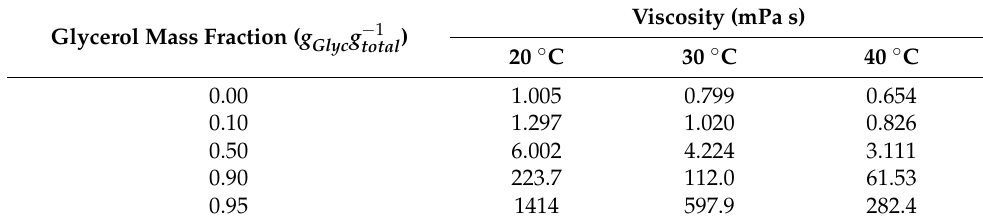
Table 1. Dynamic viscosity for the calibration mixtures at 20, 30, and 40 ◦